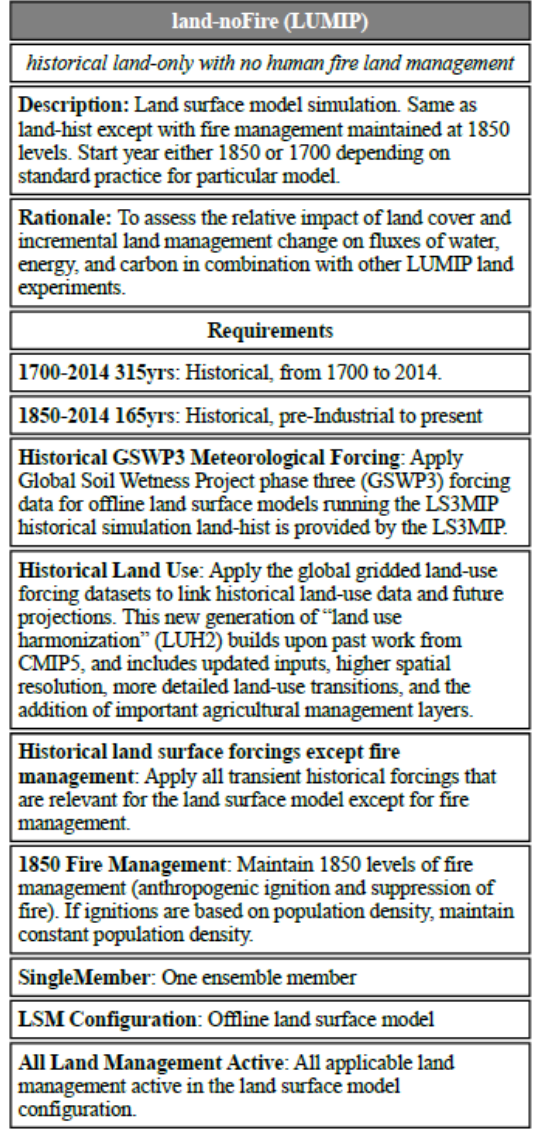
Table A2. This is an experiment that has an anti-forcing “Histori- cal land surface forcings except fire management” (note also two temporal constraint options “Start year either 1850 or 1700 de- pending on standard practice for particular model.”). See https://